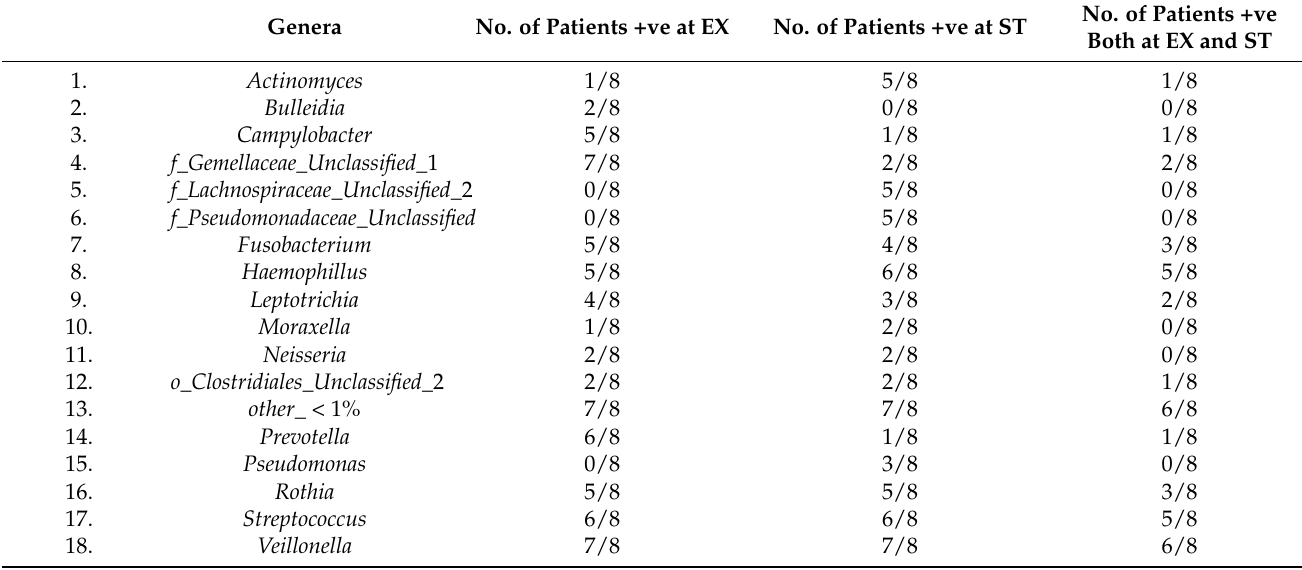
Table 4. The presence or absence of each genus in the EX and ST states in the study. Genera